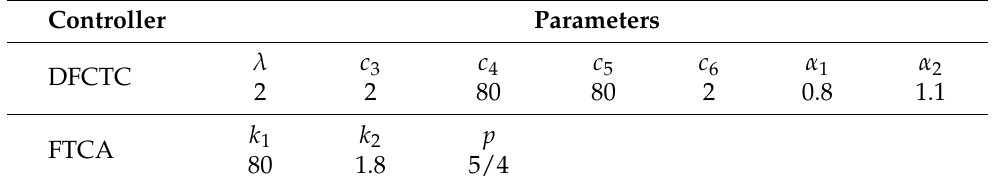
Table 2. Parameters of the DFCTC and the